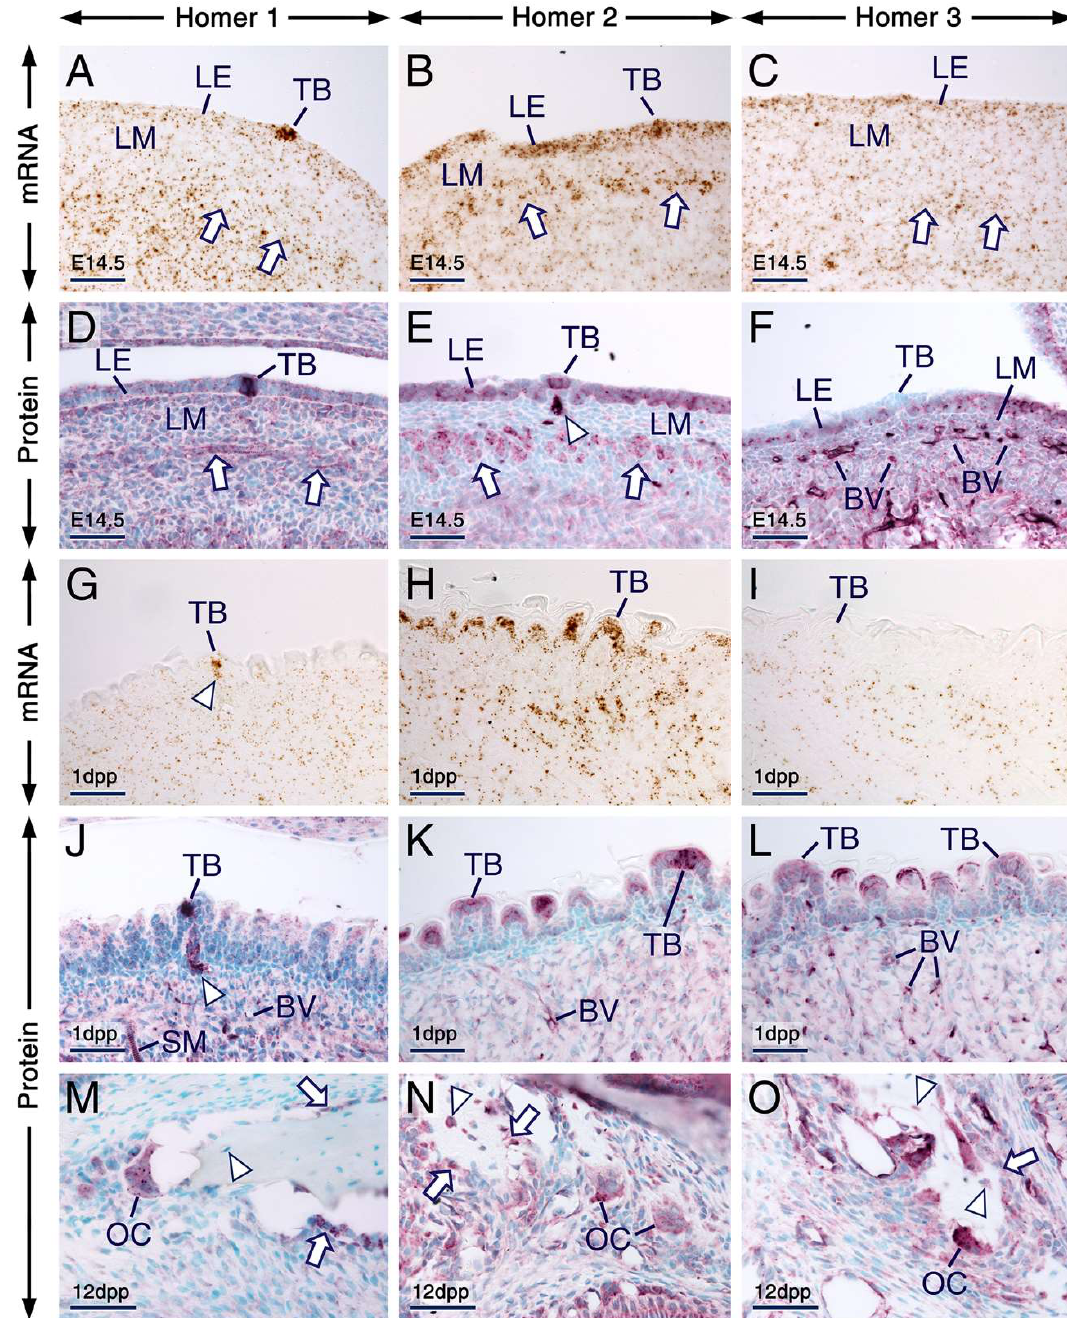
Figure 7. Expression patterns of Homer1, Homer2 and Homer3 in the tongue and alveolar bone. ( A – O ) Representative in situ hybridization ( A – C , G – I ) and immunohistochemistry ( D – F , J – O ) data showing the distribution patterns of Homer transcripts (brown) and Homer proteins (purple). ( A – F ) Sections across the developing tongue at embryonic day 14.5 (E14.5). Homer1 mRNA ( A ) and Homer1 protein ( D ) are enriched in developing taste buds and are detectable in the lingual epithelium (LE), developing muscles of the tongue (arrows) and in the lingual mesenchyme (LM). Homer2 mRNA ( B ) and Homer2 protein ( E ) are expressed in the LE, including in developing taste buds and are enriched in developing muscle of the tongue (arrows). Homer2 protein is also detectable in nerves innervating developing fungiform papillae (arrowhead in E ). Homer3 mRNA ( C ) and Homer3 protein ( F ) are expressed in the LE, LM and in the vascular endothelium, whereas developing taste buds are virtually devoid of Homer3 immunostaining. ( G – L ) Sections across the tongue at 1 day postpartum (1 dpp). Homer1 mRNA ( G ) and Homer1 protein ( J ) are enriched in nerves innervating fungiform papillae (arrowheads in G , J ) and in taste buds. The LE and taste buds express Homer2 mRNA ( H ) and Homer2